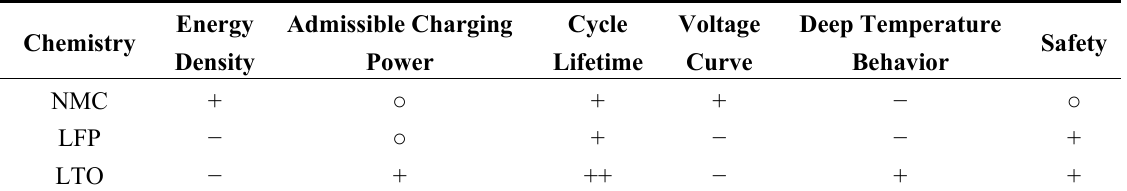
Table 5. Comparison of Li-ion battery chemistries with potential interest for public transport (good (+), poor ( − ), neutral ( ○